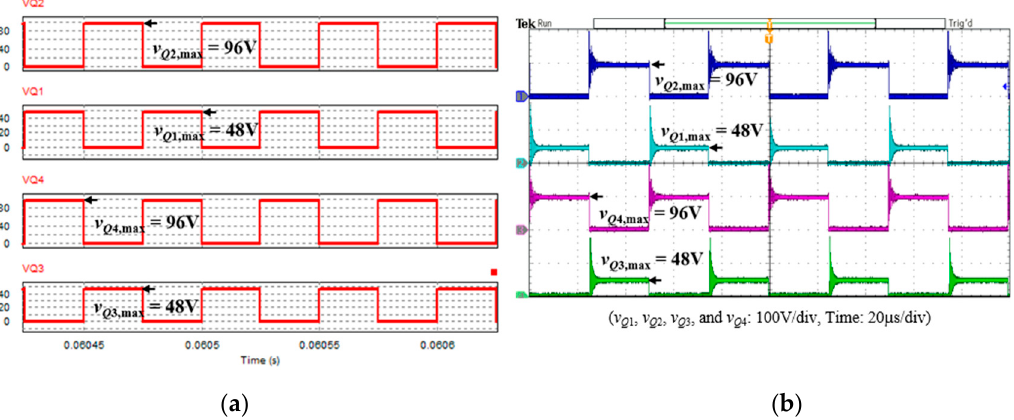
Figure 17. The waveform of switching voltage across the power devices in the battery charge mode with D c = 0.5: ( a ) simulated and ( b ) experimental.